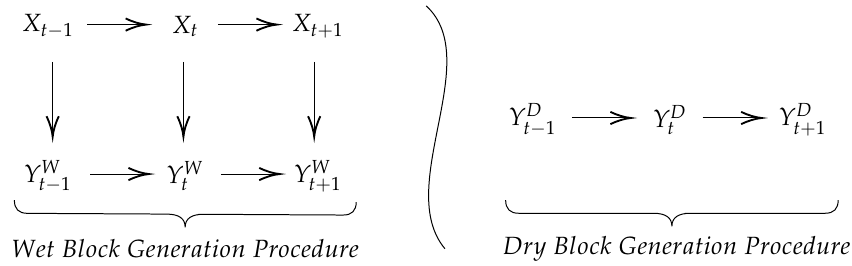
Figure 2. Proposed bivariate (intermittent process X t , continuous process Y t ) generation algorithm explanatory diagram. Superscripts W and D denote the conditional wet and dry continuous process marginal distributions,